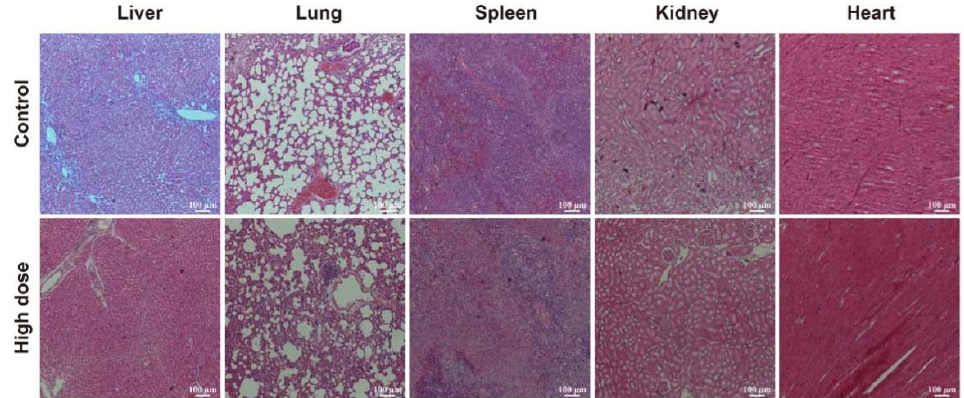
Figure 6. H&E staining showing the effects of high ‐ dose DhHP ‐ 6 on the heart, lung, liver, spleen, and kidney of rats. Scale bars represent 100 μ m.